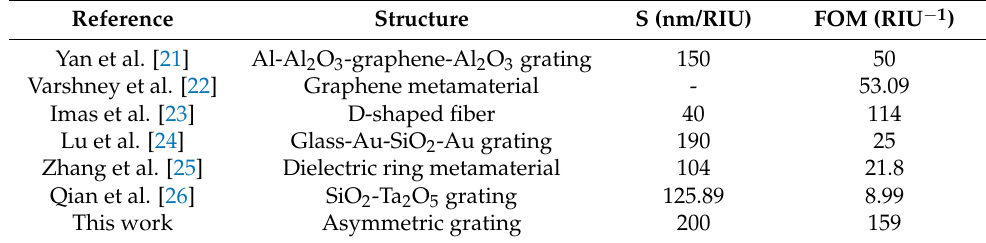
Table 1. Comparison on sensitivity and FOM between this work and previous